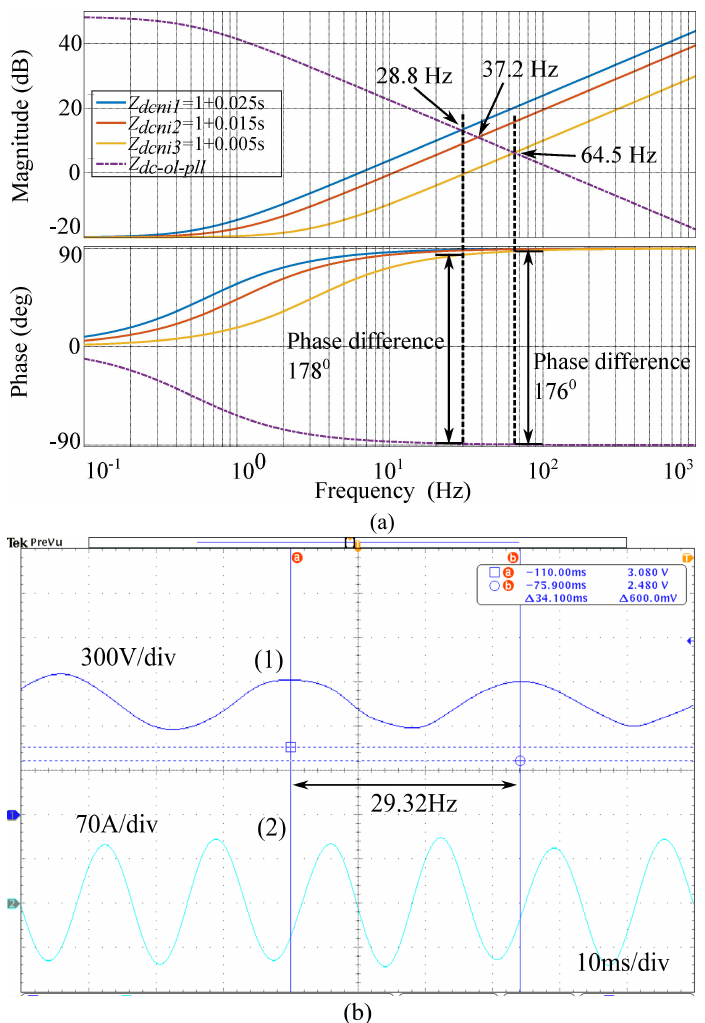
Figure 7. In open loop mode, the converter operates with d = 0.11 ( a ) A Bode plot shows the DCIM with various DCNIs, ( b ) Test result with DCNI: (1) DC link voltage, (2) Grid